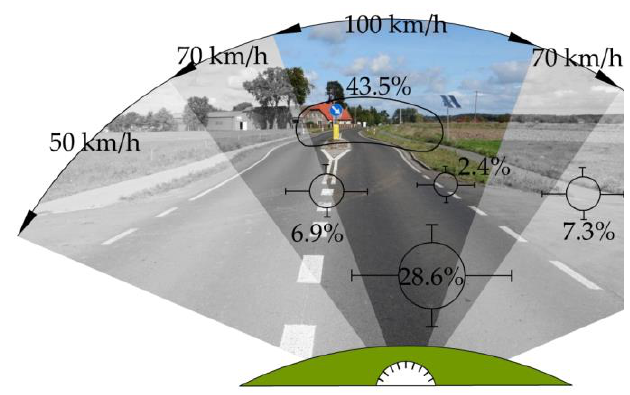
Figure 18. Conclusions of the studies by authors [26,27]. Source: own work of the authors.